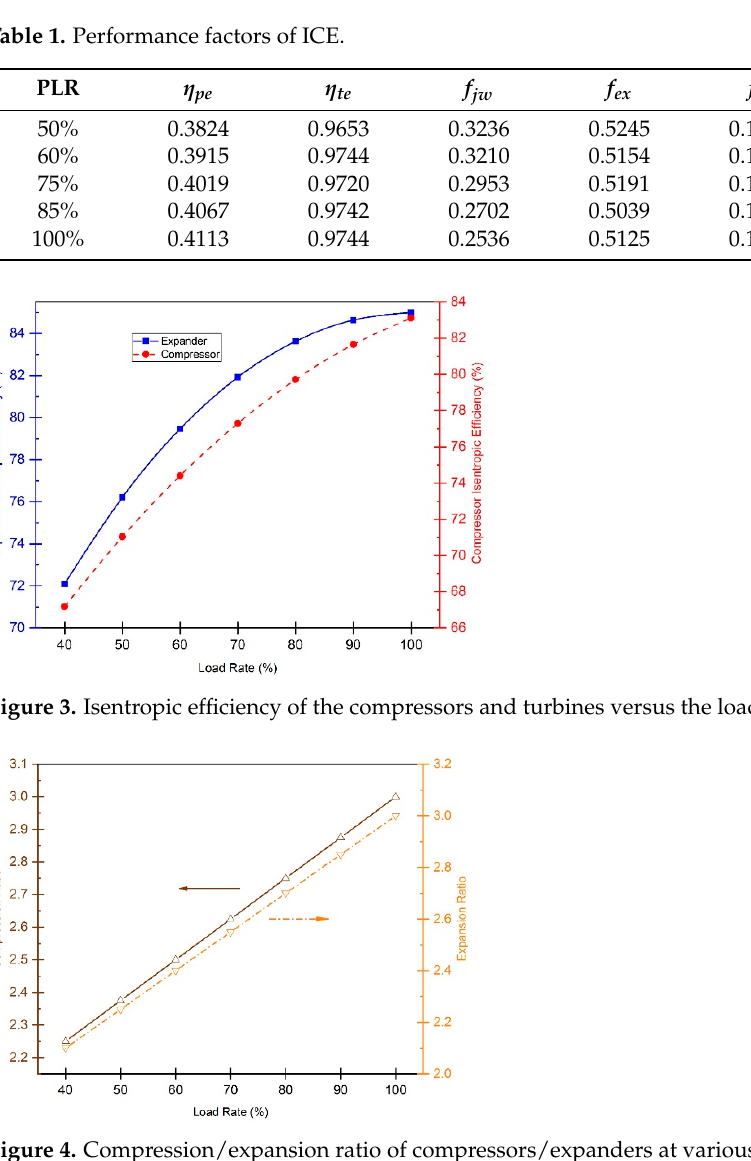
Figure 4. Compression/expansion ratio of compressors/expanders at various load levels.